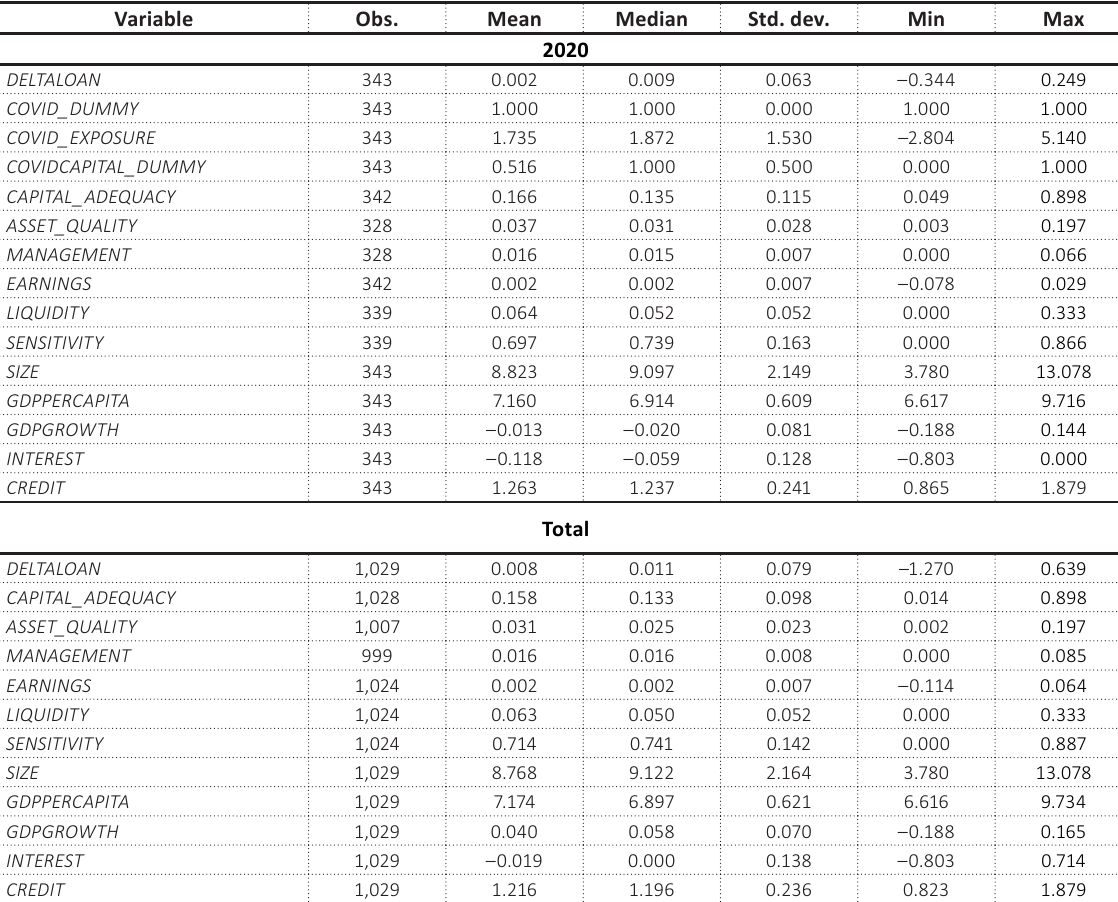
Table 2 (cont.). Descriptive statistics